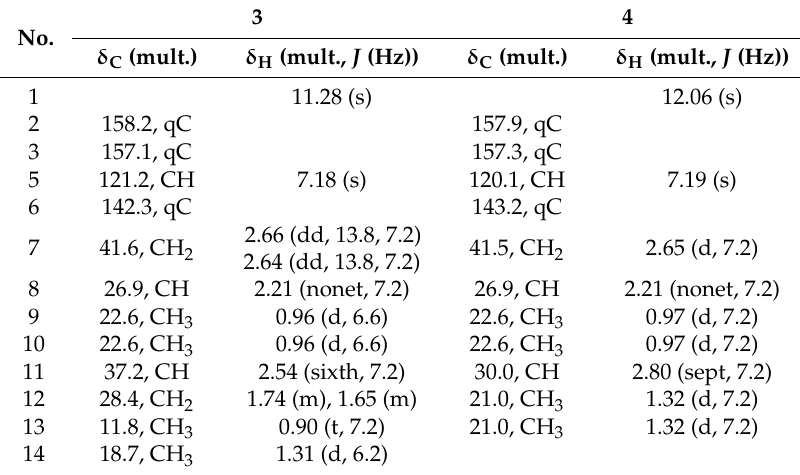
Table 2. NMR data of compounds 3 and 4 (600 and 150 MHz, CDCl 3